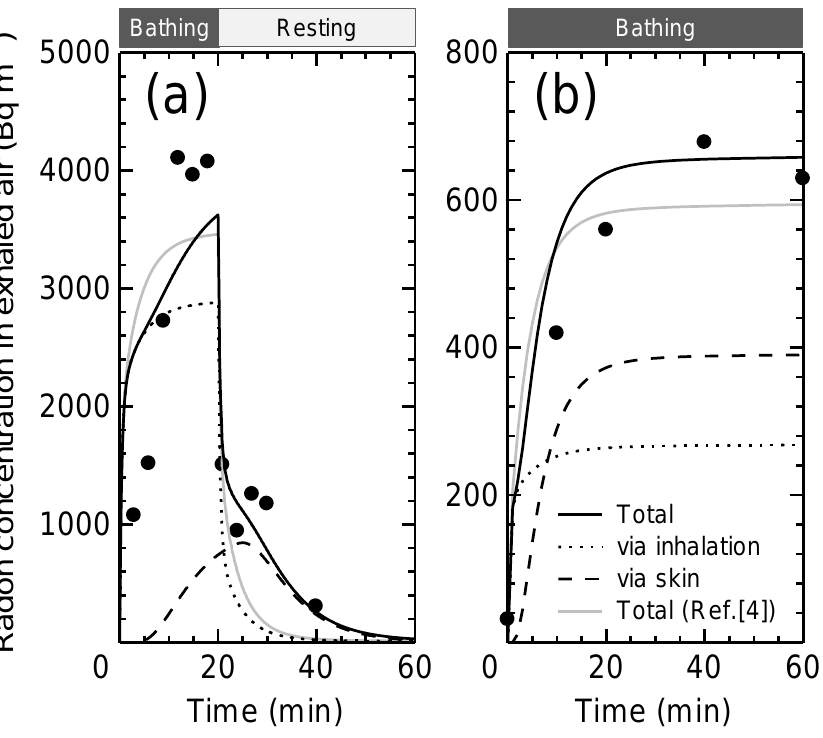
Figure 3. Comparison of radon activity concentrations in exhaled air during and after immersion in thermal water between model estimates and human experiments. Experimental data: ( a ) Tempfer et al. [17] and ( b ) Furuno [18]. The exposure conditions are summarized in Table 3. The solid curves were obtained by the use of the best estimated D SC values. The curves (“Total”) were then divided into inhalation and dermal uptake, taking into consideration the contribution of each exposure route. The best-fitted data given by the previous model are depicted as well [4]. Table 3. Summary of human volunteer experiments and values of D SC estimated by the present model.